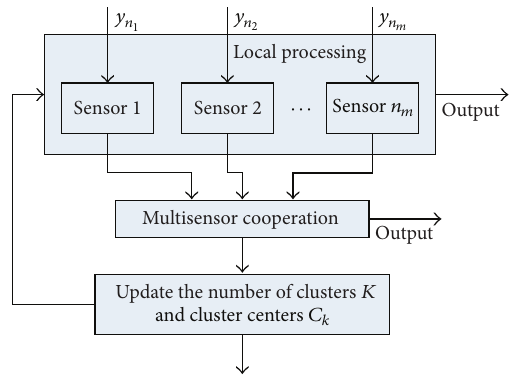
Figure 3: The framework of online multisensor fusion clustering. It is composed of local processing and multisensor fusion. The local processing uses simple and fast algorithm to cluster the intercepted pulses.Themultisensorfusionusestheresultsofthelocalprocessing to cluster the radar emitter pulses further, and then the numbers of clusters and cluster centers are updated on the basis of multisensor